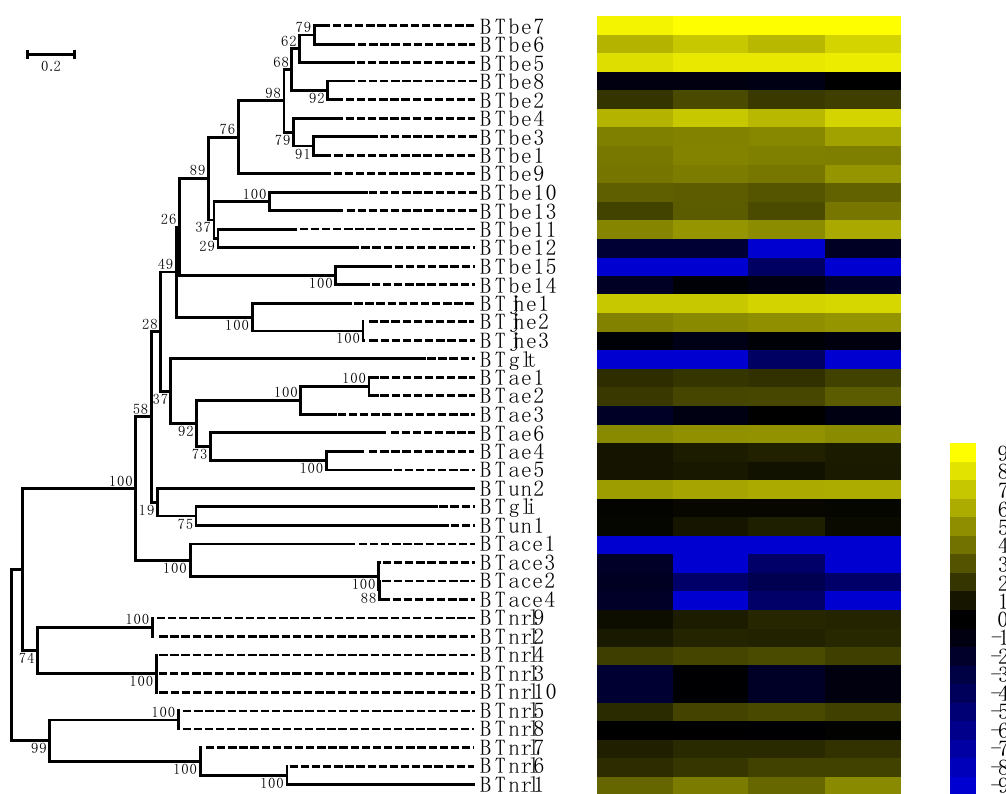
Figure 4. Expression of COE genes in B. tabaci MED adults treated with an imidacloprid gradient. A total of 14 COE amino acid sequences of B. tabaci MED were aligned by MUSCLE, and the phylogenetic tree was constructed by MEGA 6.0 using the NJ method based on the JTT model with a uniform substitution rate. Bootstrap values displayed at branch points are expressed as percentages of 1000 replicates. The color scale is displayed on the right side; yellow represents higher expression values (log2-transformed FPKM values), while blue represents lower expression values (log2-transformed FPKM values). IM0, whitefly treated with water; IM25, whitefly treated with 25 mg / L imidacloprid; IM50, whitefly treated with 50 mg / L imidacloprid; IM100, whitefly treated with 100 mg / L imidacloprid.